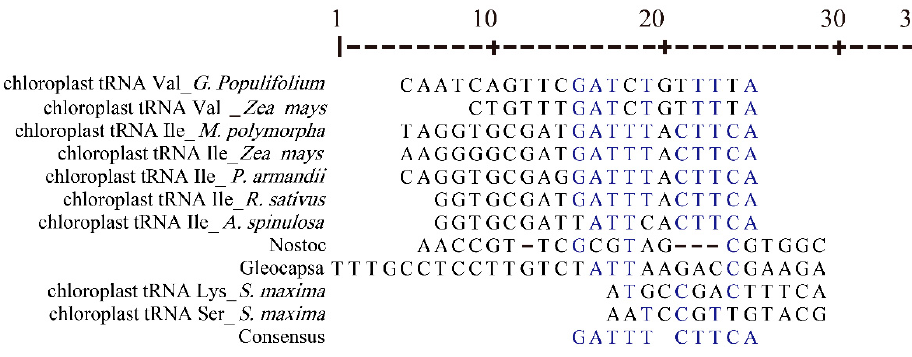
Figure 2. Multiple sequence alignment of introns in tRNA of plant chloroplast and cyanobacteria. Introns in bacterial and chloroplast tRNAs had conserved G-A-T-T-T and C-T-T-C-A consensus sequences.